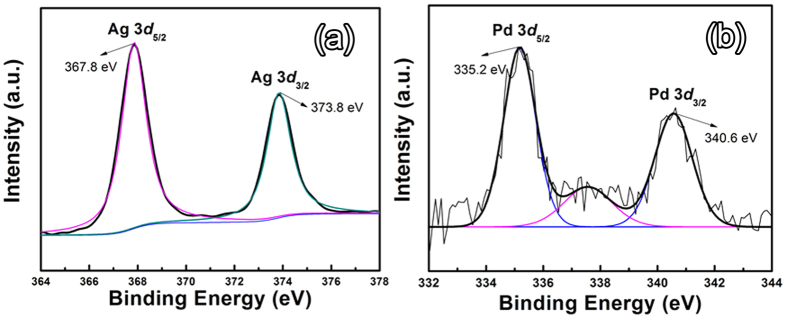
High resolution XPS spectra of (a) Ag3d and (b) Pd3d peaks recorded from the typical Ag-Au-Pd sample.